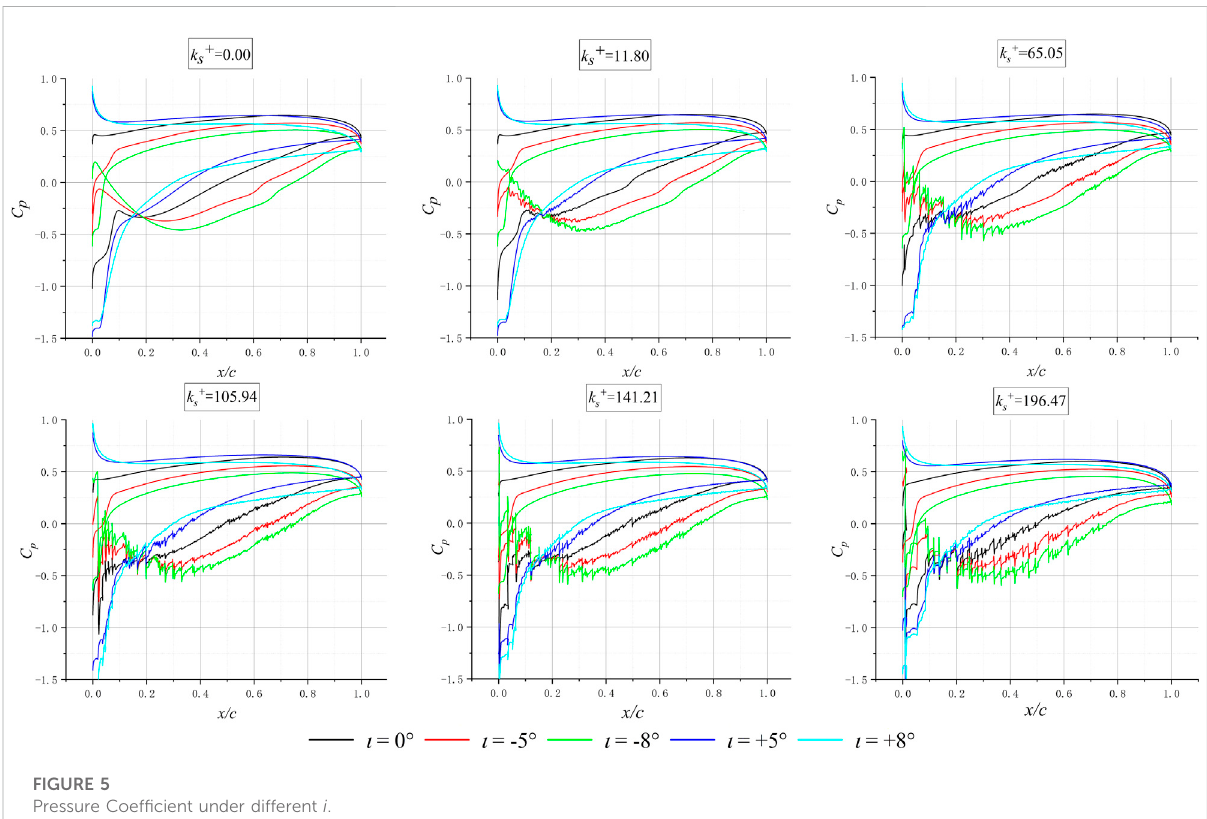
FIGURE 5 Pressure Coef fi cient under different i .